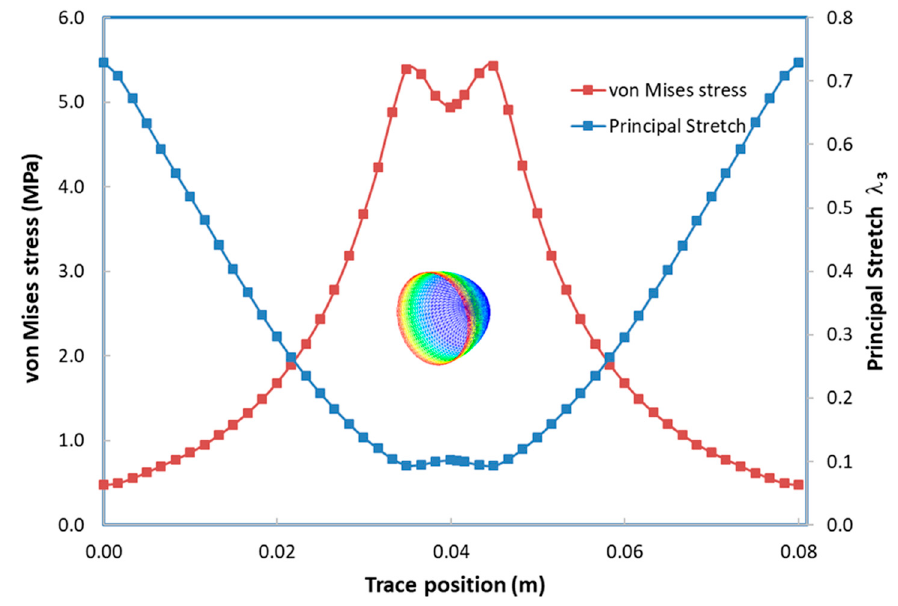
Figure 17. Von Mises stress and stretch ratio, λ 3 , on the half plane of symmetry at the end of the forming cycle.